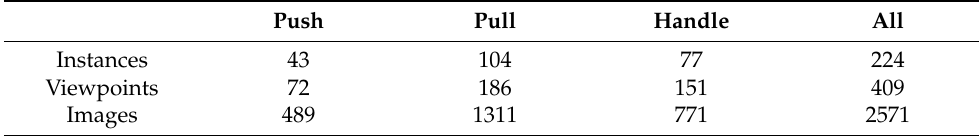
Table 1. Distribution of object instances, viewpoints, and images per